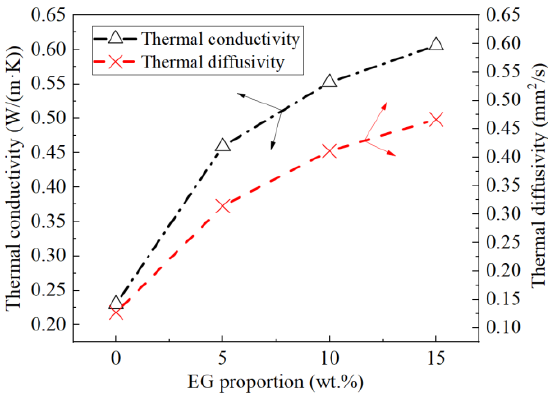
Figure 11. Thermal conductivity and thermal diffusivity.